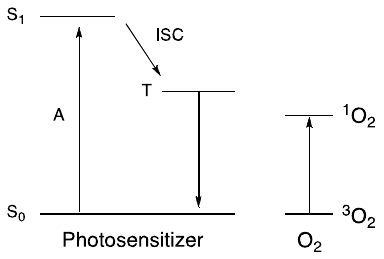
Figure 18. Energy level diagram illustrating the formation of 1 O 2 . A denotes absorption, ISC intersystem crossing, S states with singlet and T states with triplet multiplicity.